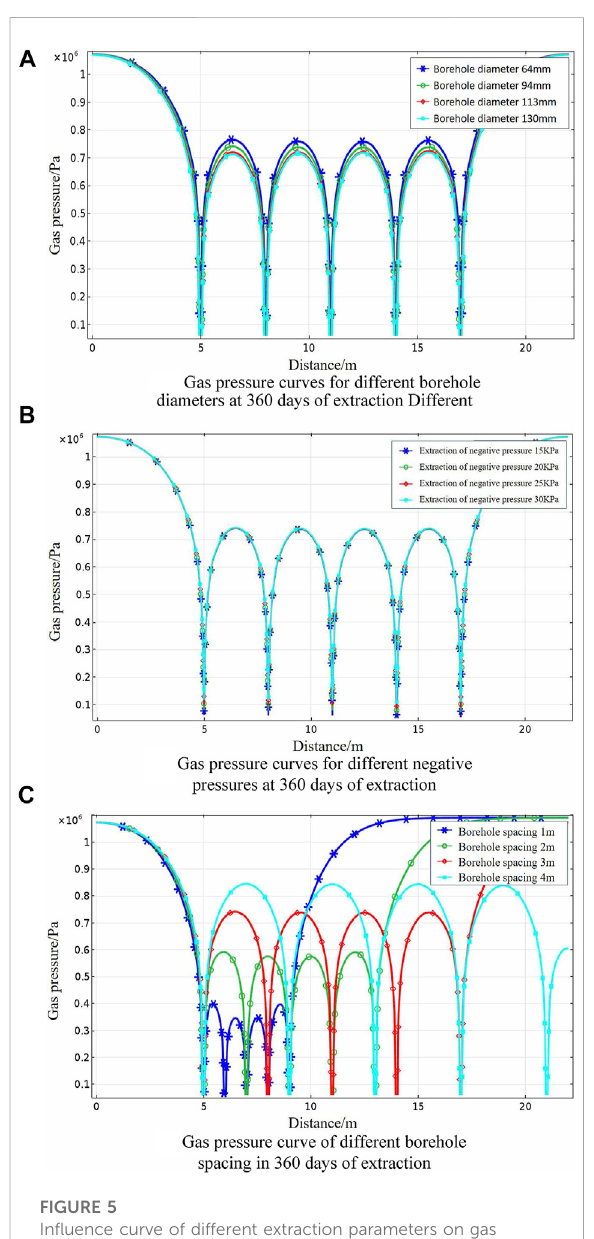
FIGURE 5 In fl uence curve of different extraction parameters on gas pre-extraction effect in working